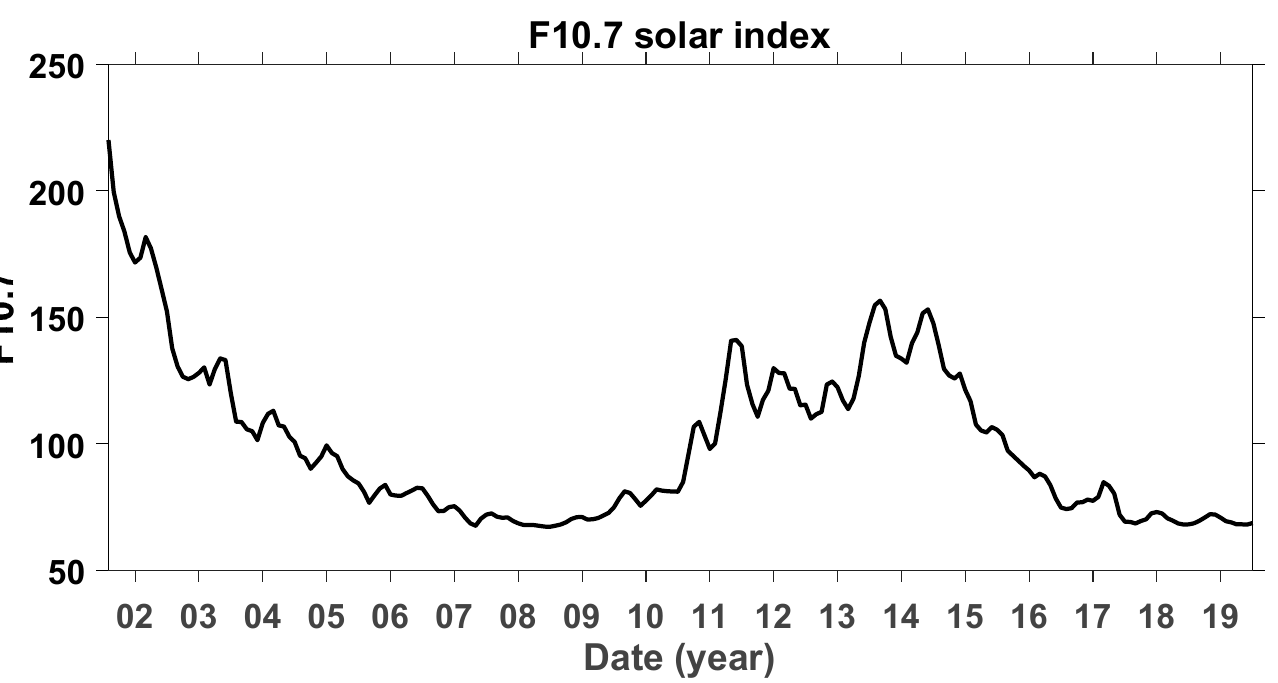
Figure 1. Temporal variations in the F10.7 solar index from 2002 to 2019. Figures 2 and 3 show the temporal variations in the meridional and vertical circulation at different latitudinal regions. Clear seasonal variations in the meridional and vertical circulation are shown in the global atmosphere, excluding the regions near 10 − 4 hPa and the lower atmosphere. The meridional circulation is mainly characterized by a flow from the summer hemisphere to the winter hemisphere. The vertical circulation shows a rise in the summer hemisphere and a fall in the winter hemisphere in mid- and high-latitude regions. However, in low-latitude and equatorial regions, the vertical circulation shows a fall in the summer hemisphere and a rise in the winter hemisphere, which is opposite to that in mid- and high-latitude regions. The amplitudes of meridional circulation at the same moment do not differ much in different latitude regions, whereas the vertical circulation shows highest and lowest intensity in high- and low-latitude regions, respectively. In addition, both intensities of the meridional and vertical circulation in the upper atmosphere are higher in years with high solar activity than in years with low solar activity, with the highest intensity in 2002. The temporal variations in the meridional and vertical circulation at different latitudinal regions are shown in Figure 4. The meridional and vertical circulations at ~50 and ~90 km show local maximum amplitudes in mid- and low-latitude and equatorial regions. They do not exhibit stronger intensity during the years with high solar activity but instead show quasi-biennial variations in low-latitude and equatorial regions. The vertical circulation at ~90 km shows the most obvious quasi-biennial oscillation. At ~130 and ~170 km, the local maximum amplitudes of meridional and vertical circulations are mainly observed in mid- and high-latitude regions. These local maximum meridional and vertical circulations are clearly enhanced during those years with high solar activity. In mid- and low-latitude regions, these meridional and vertical circulations show almost identical intensities during different solar